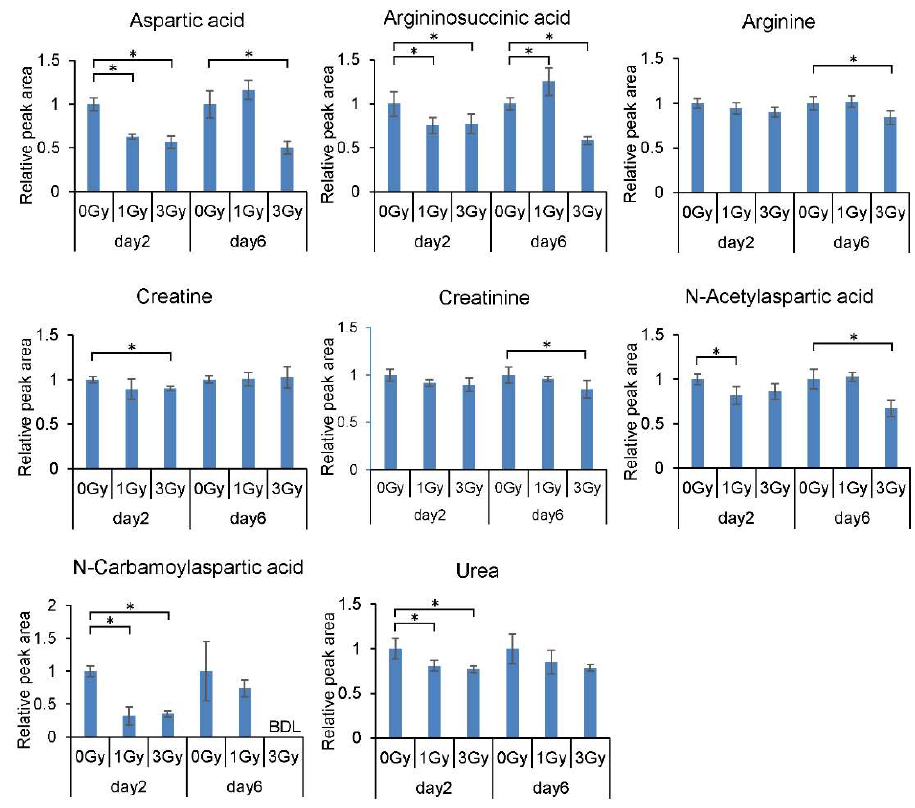
Figure 2. Dose and time response of levels of metabolites related to aspartic acid, urea, and creatinine metabolism in mouse blood cells. All quantitative data are means ± SD. * p < 0.05.